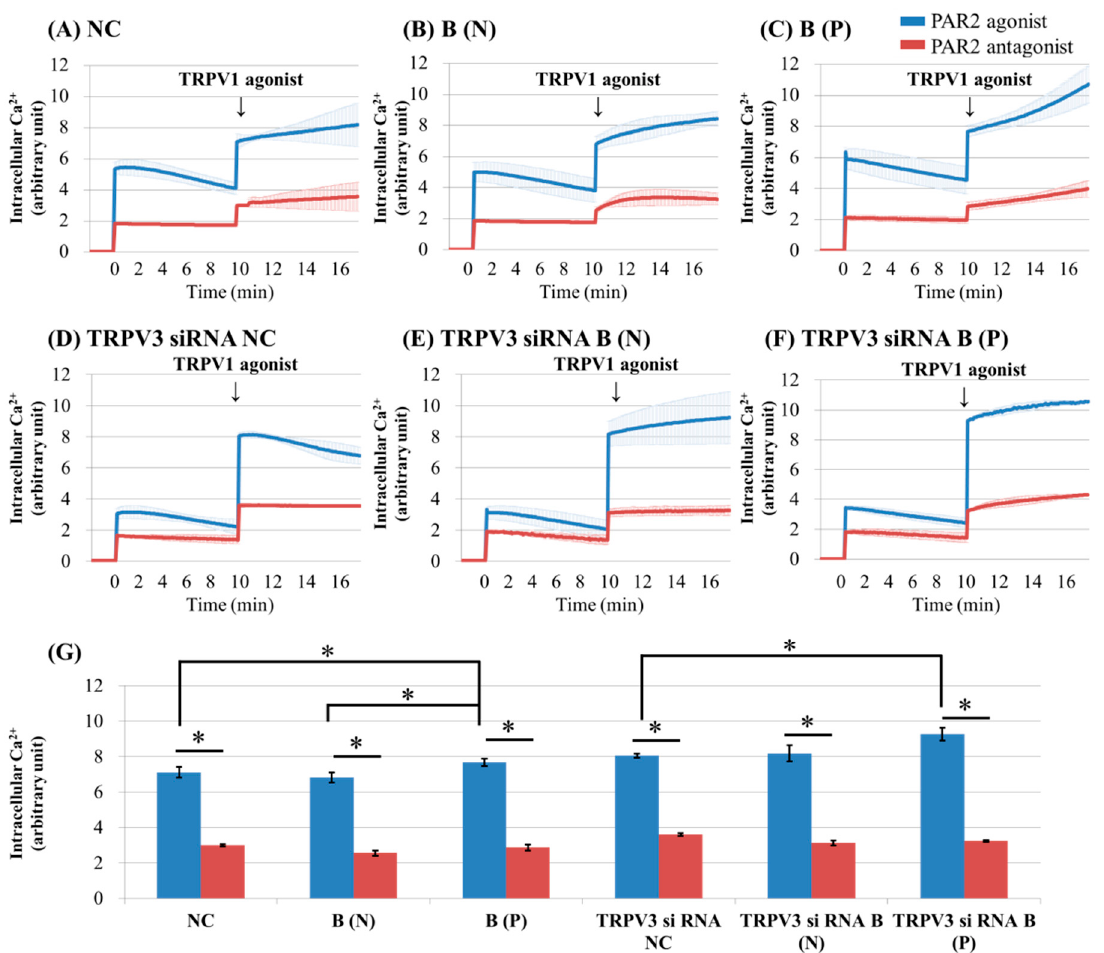
Figure 3. Ca 2+ influx in cultured keratinocytes of: ( A ) Normal control; ( B ) nonpruritic burn scar; ( C ) pruritic burn scar; ( D ) TRPV3 siRNA transfected normal control; ( E ) TRPV3 siRNA transfected nonpruritic burn scar and ( F ) TRPV3 siRNA transfected pruritic burn scar; ( G ) intracellular Ca 2+ levels at the time of TRPV3 agonist treatment. Each group was pretreated with PAR2 agonist (100 uM SLIGRL-NH2) or PAR2 antagonist (100 uM LRGILS-NH2); then TRPV1 agonist (1 uM Capsaicin) was added. PAR2 agonist induced intracellular Ca 2+ influx in cultured human keratinocytes of normal (unscarred), and in nonpruritic and pruritic burn-scar tissues. After treatment with TRPV3 agonist, intracellular Ca 2+ slowly increased in all keratinocyte groups except for TRPV3 siRNA transfected normal control keratinocyte. NC: keratinocytes from normal control; B (N): keratinocytes from a nonpruritic burn scar; B (P): keratinocytes from a pruritic burn scar; Error bars in ( A – F ): standard deviation of the mean value obtained from three experiments; Error bars in ( G ): standard error, each performed in triplicate.* p < 0.001.